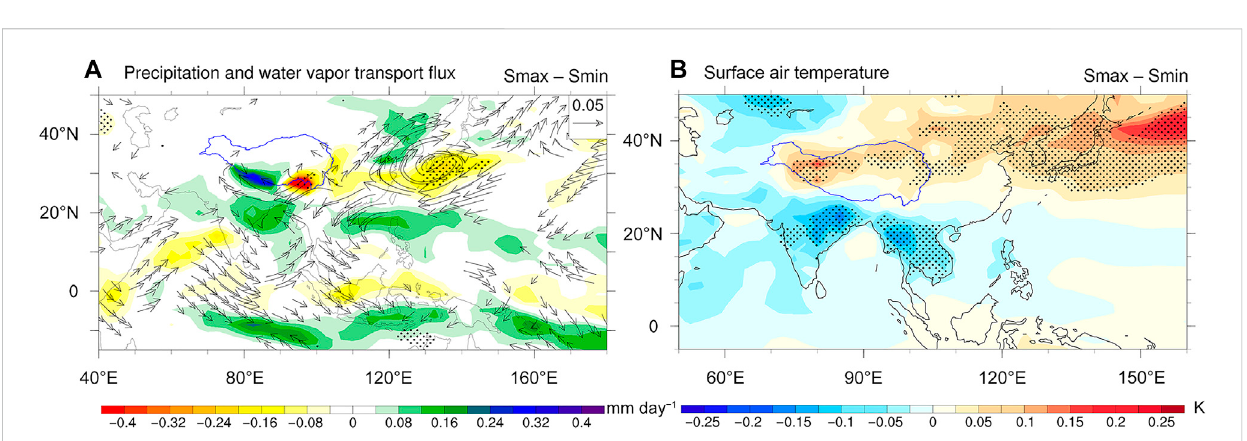
FIGURE 4 Composite differences in JJA mean precipitation (shading, mm day − 1 ) overlain on the (A) water vapor transport fl ux (kg · m − 1 s − 1 ) and (B) surface air temperature (K) between the 11-year Smax and Smin phases from the ensemble-mean result of four TSI experiments in the CESM ‒ LME. The black dots denote signi fi cance at the 90% con fi dence level (two-tailed Student ’ s t